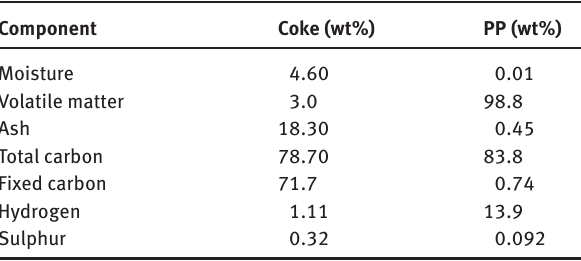
Fig. 1: Blend compositions of the carbonaceous materials used Table 1: Chemical composition of coke and PP